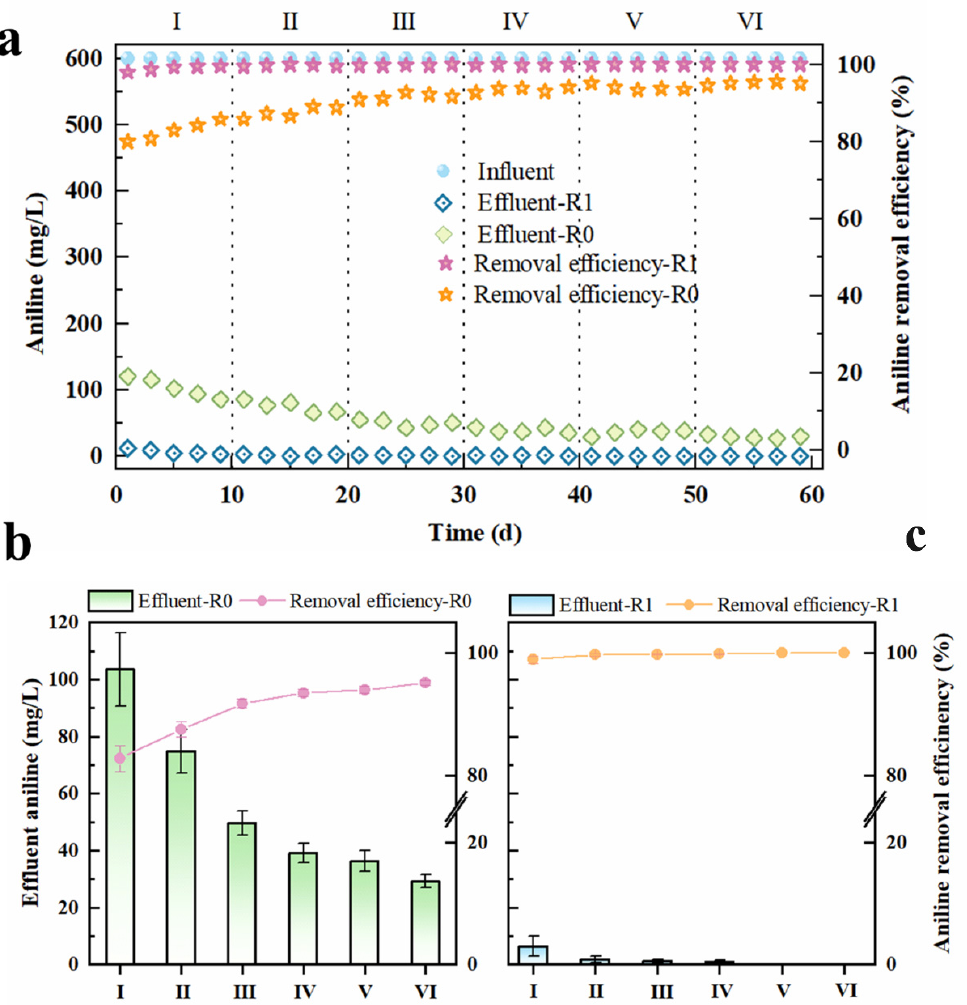
Figure 1. Removal performances of aniline in R0 and R1 ( a ); averages of effluent aniline concentrations and aniline removal efficiency of R0 ( b ) and R1 ( c ) from all days at each phase (Phase I to VI corresponding to 300 mL · min − 1 to 800 mL · min − 1 aeration rates, respectively).